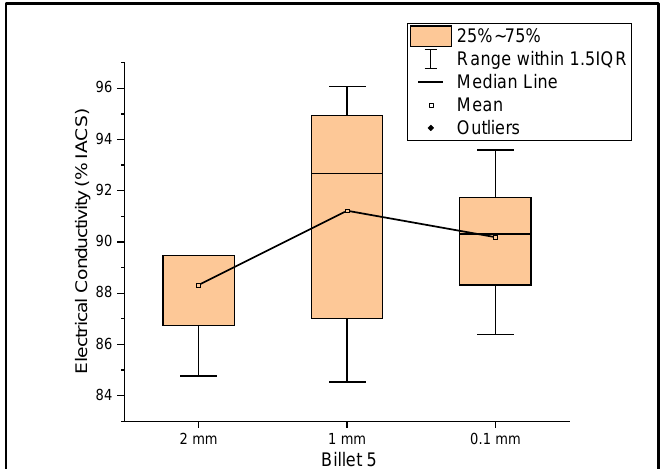
Figure 5 . The electrical conductivity of Billet 5 at different cross-sectional sizes. Figure 5. The electrical conductivity of Billet 5 at different cross-sectional